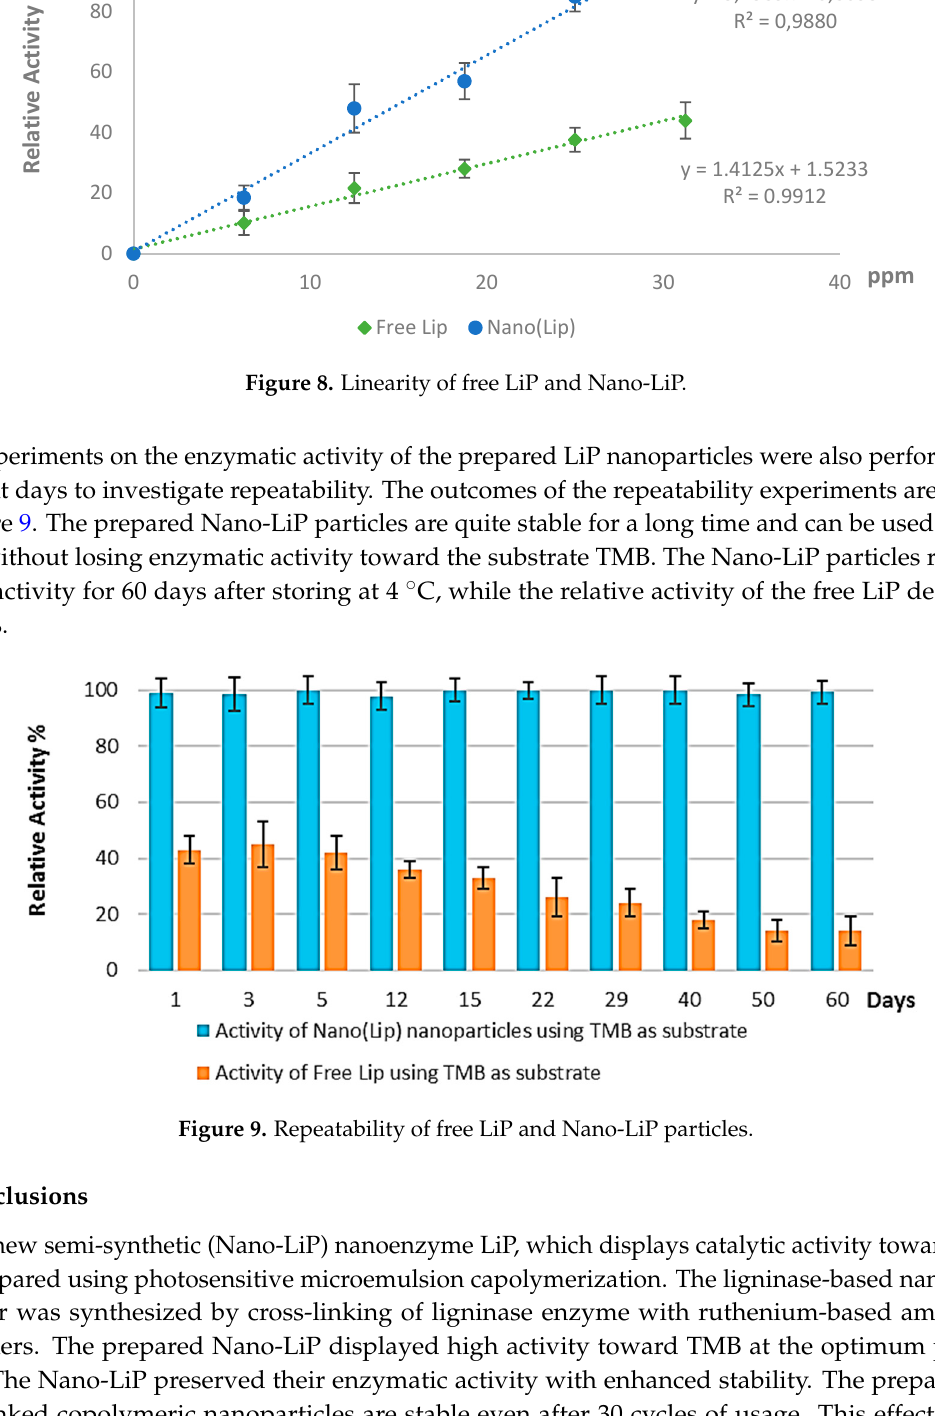
Figure 9. Repeatability of free LiP and Nano-LiP particles.